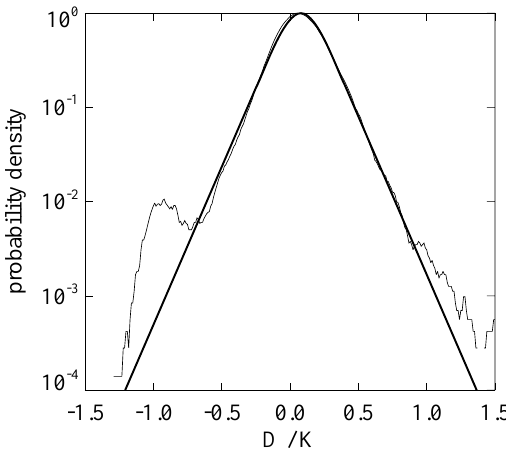
Fig. 3. Normalised probability density of observed warming D for near-zero integrated heat flux Q at 14:00LT (thin curve) and fit- ted Gaussian-exponential density function (thick curve). The me- dian warming is 0.08 K and the median integrated heat flux is 1.7MJm − 2